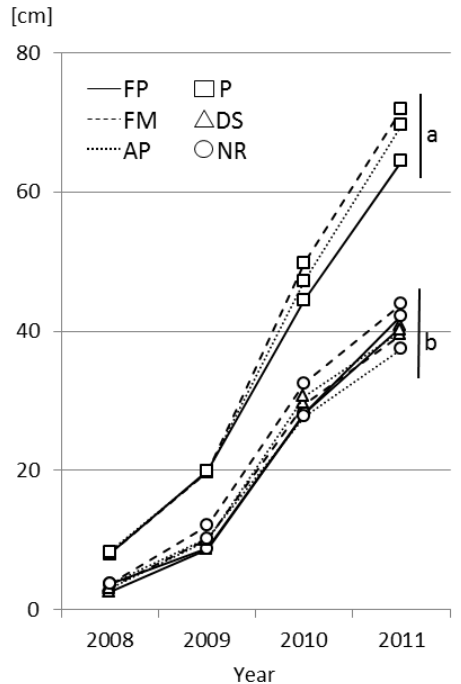
Figure 2. Mean height (cm) of Scots pine seedlings in 4 years for three reforestation methods (planting (P); direct seeding (DS); natural regeneration (NR)) and three mechanical site preparation methods (forest plough (FP); forest mill (FM); active plough (AP)). Different letters indicate significant differences in the Tukey HSD test, p ≤ 0.05.